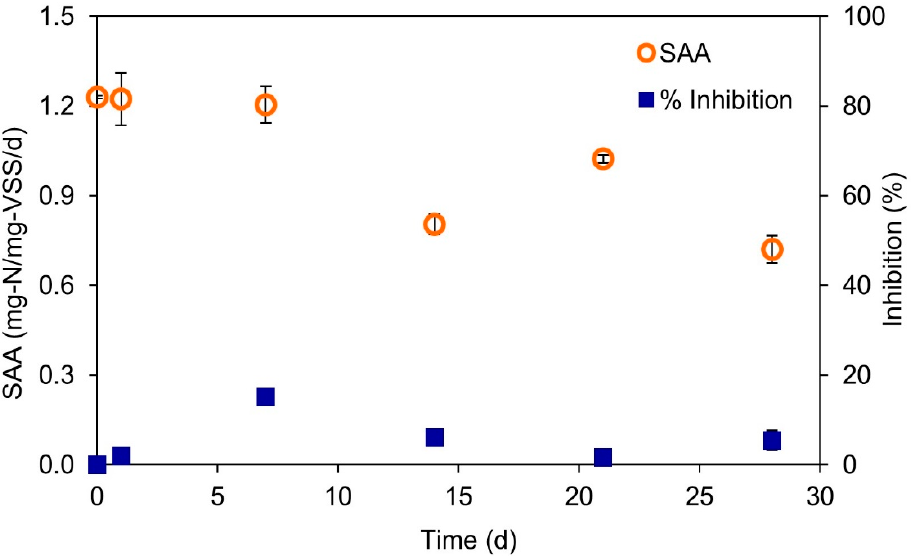
Figure 5. Specific anammox activity (SAA) of control and caffeine and inhibition (%) during the long-term caffeine dosing.